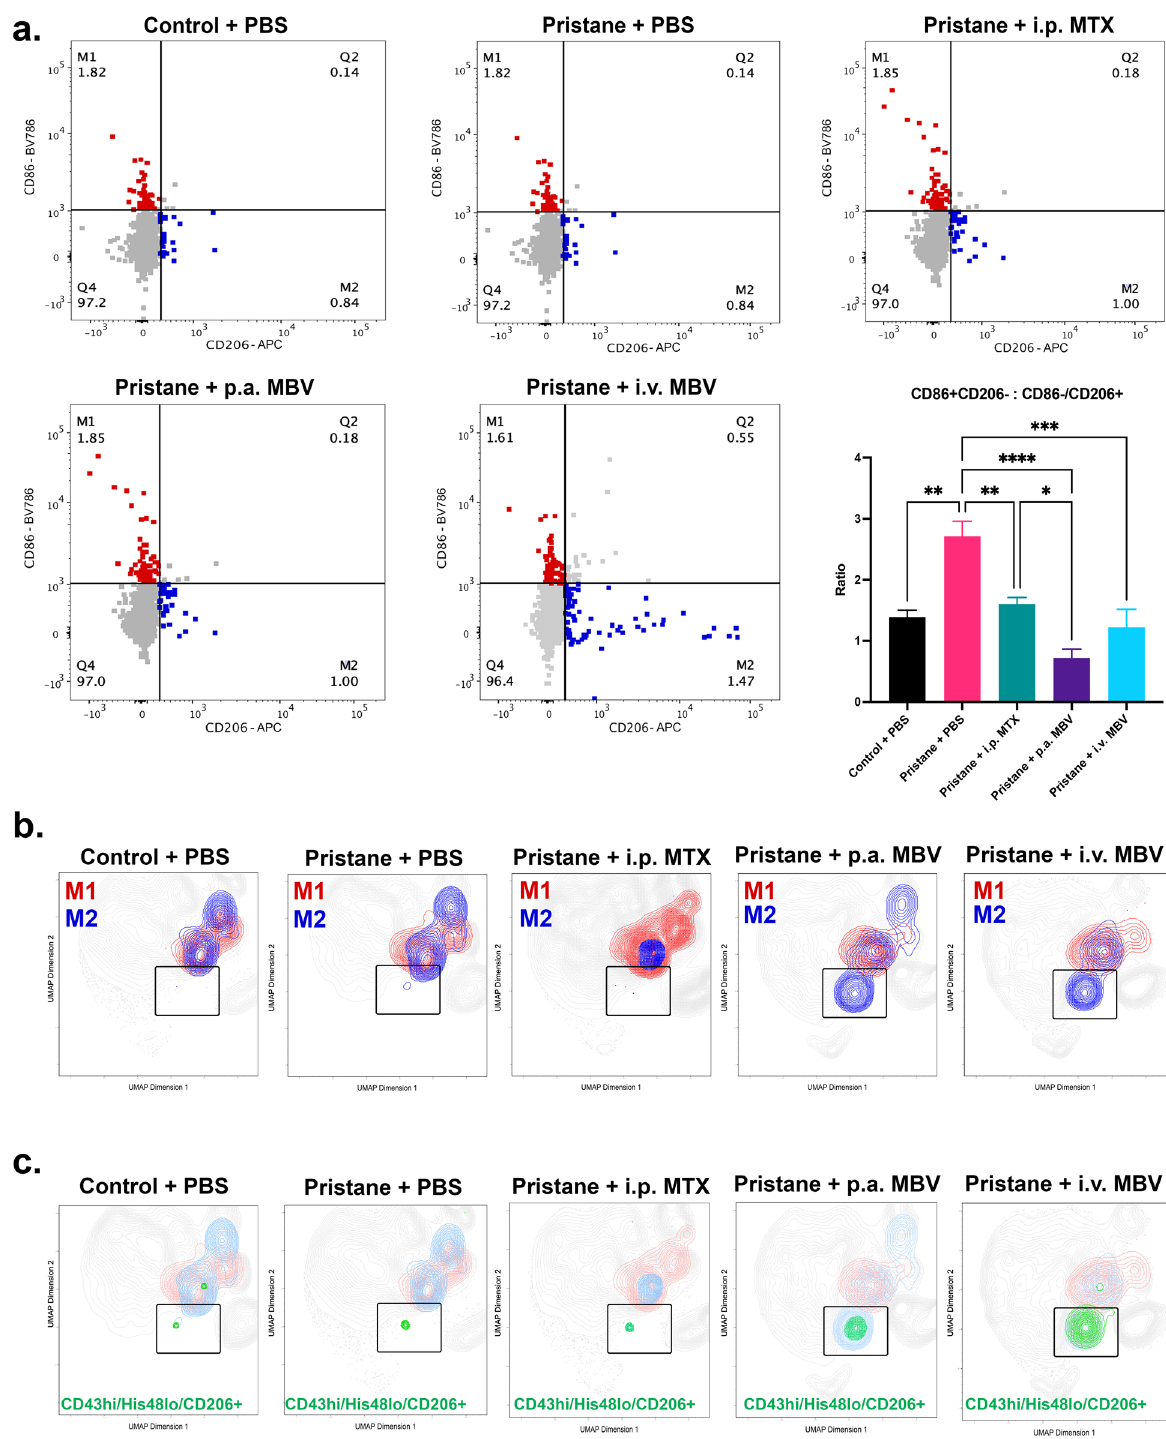
Fig. 5 Local and systemic administration of MBV decrease the ratio of splenic pro-in fl ammatory M1-like macrophages to anti- in fl ammatory M2-like macrophages and regulates a myeloid population shift driven by CD43hi/His48lo/CD206 + circulating monocytes. a i.p. MTX, p.a. MBV, and i.v. MBV decrease the ratio of splenic pro-in fl ammatory, M1-like macrophages (CD68 + /CD86 + /CD206 − ) to anti- in fl ammatory, M2-like macrophages (CD68 + /CD86 − /CD206 + ) compared to Pristane + PBS ( p < 0.05). b UMAP dimensional reduction of the entire splenic myeloid compartment revealed an M2-predominant cluster as outlined in rectangular outline that is unique to MBV treatment. c The M2-predominant cluster unique to MBV treatment is driven by immunoregulatory, CD43hi/His48lo/CD206 + circulating monocytes in the spleen. All values in panels a represent mean ± s.e.m. ( n = 4). UMAP plots in b and c represent concatenated values of four biological